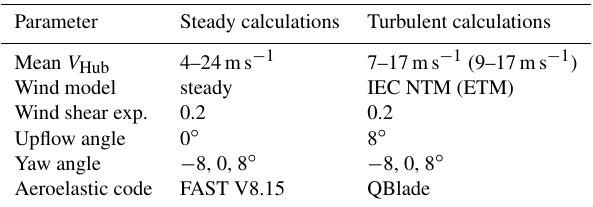
Table 1. Simulation parameters for aeroelastic